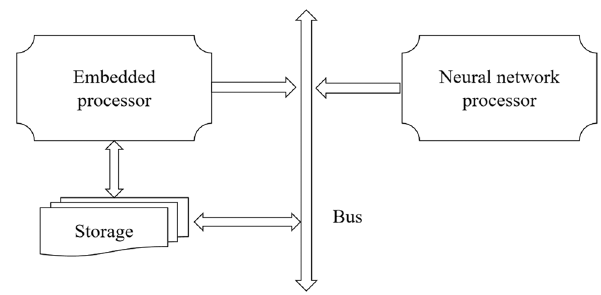
Figure 4: System model of bus